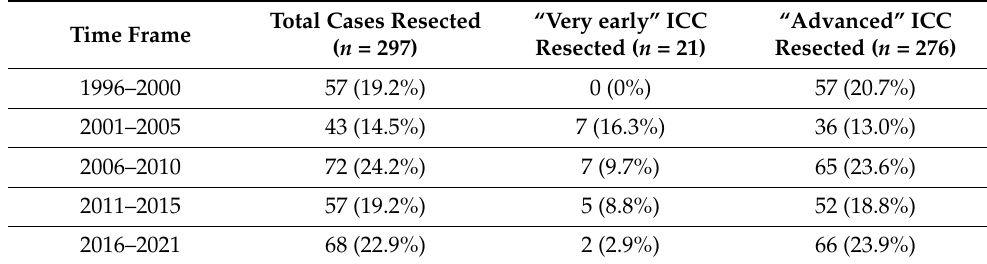
Table 2. Number of cases with intrahepatic cholangiocarcinoma (ICC) resected over the analyzed period of 25 years.